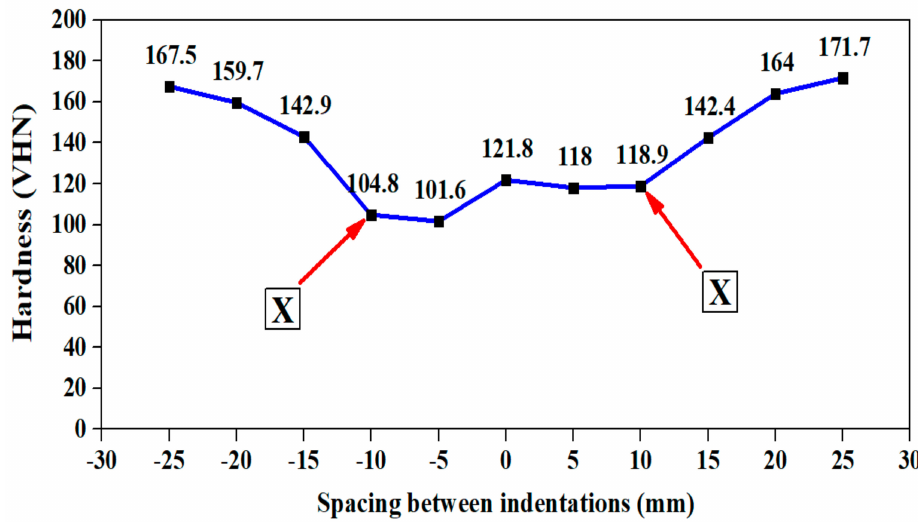
Figure 3. Hardness Map for 900-90 joint. X–Hardness transition